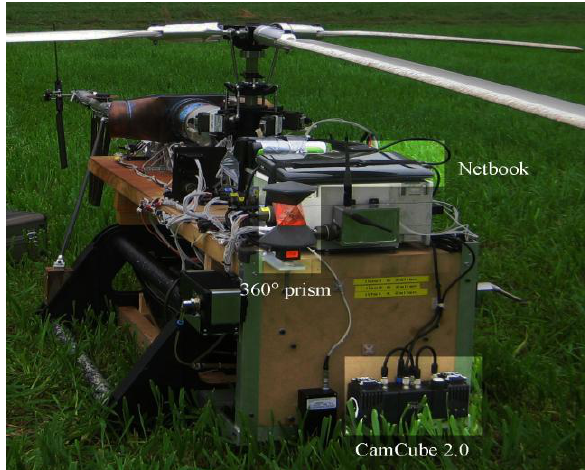
Figure 5 Experimental NEO platform with CamCube 2.0, 360° prism and standard Netbook.